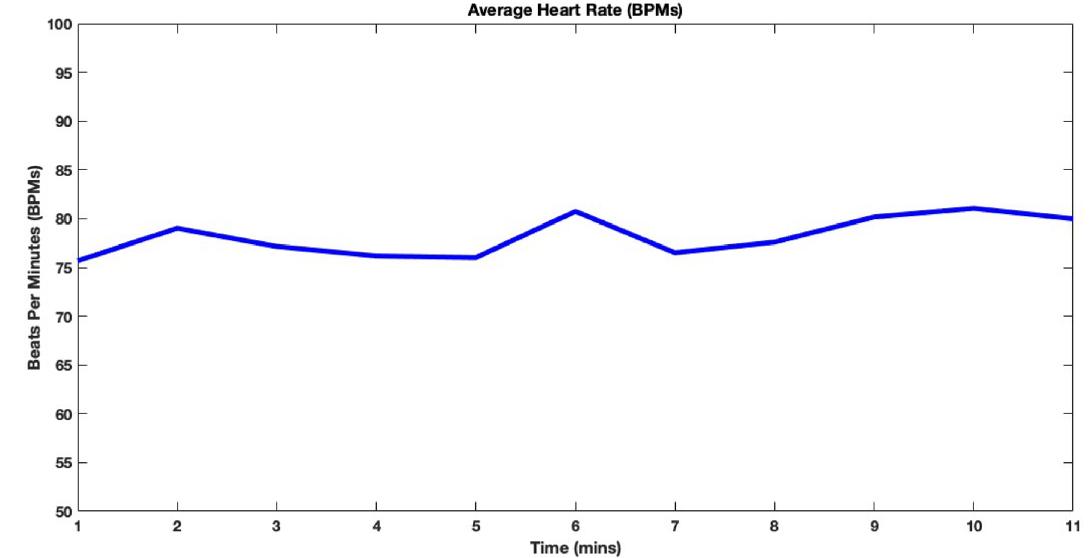
Figure 6. Real time heart rate values in bpm for subject under consideration.